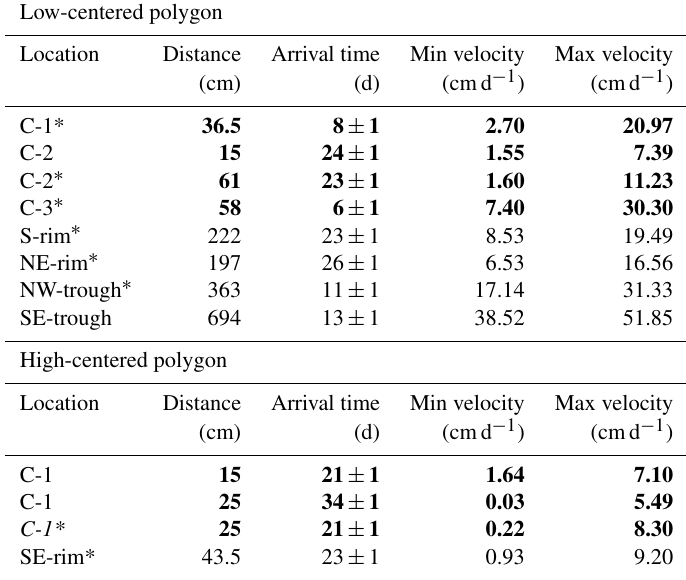
Table 2. Tracer breakthrough locations, times, and linear velocities. Italic text indicates uncertainty in tracer arrival time due to insufficient data for interpolation. The ∗ symbol denotes samplers at frost table depth. Bold font denotes vertical flow (center wells) and normal font denotes horizontal